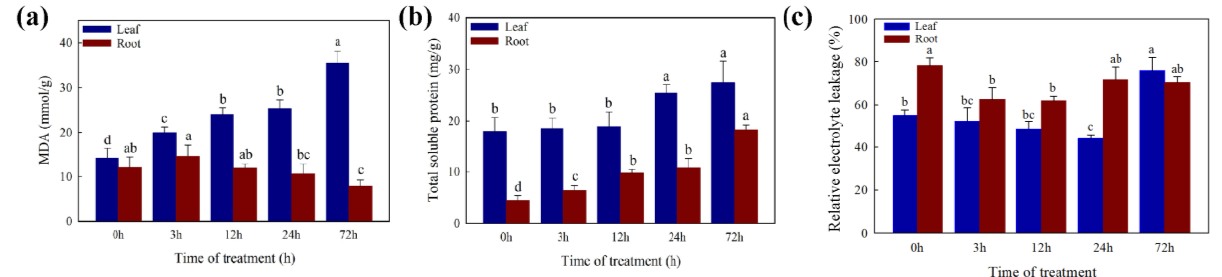
Figure 3. Measurement of ( a ) MDA, ( b ) soluble protein, and ( c ) electrolyte leakage levels. Different letters (a–d) in the figures indicate significant differences at p < 0.05 level among different time points in the same tissue.